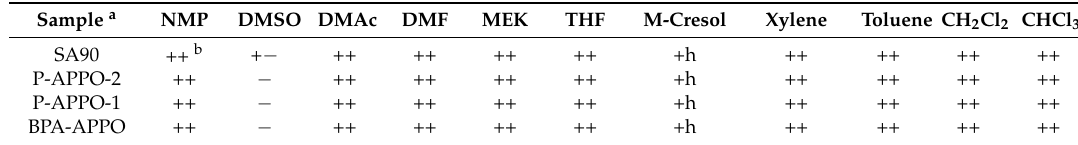
Table 1. Solubility data of SA90, P-APPO-1, P-APPO-2, and